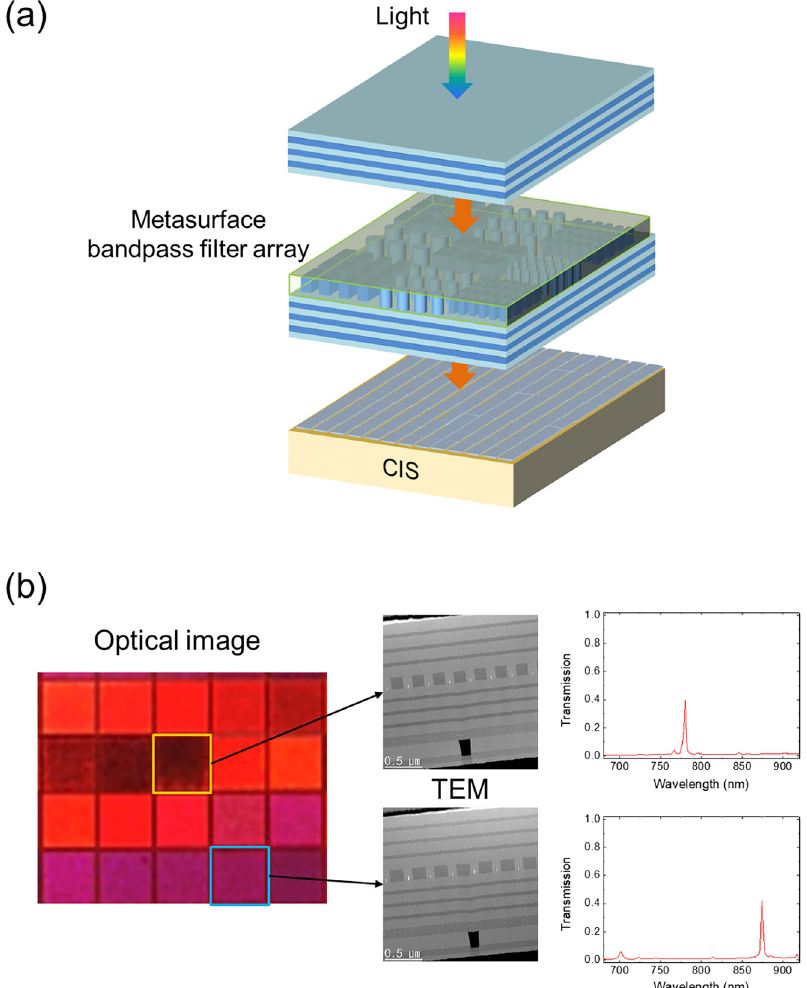
Figure 1: Meta-spectral imager. (a) Schematic of the meta-spectral imager. (b) Optical microscope image of one pixel made of 20 channels (left). Cross-sectional transmission electron microscope (TEM) images of the two channels (center). The measured transmission spectra of the two selected channels